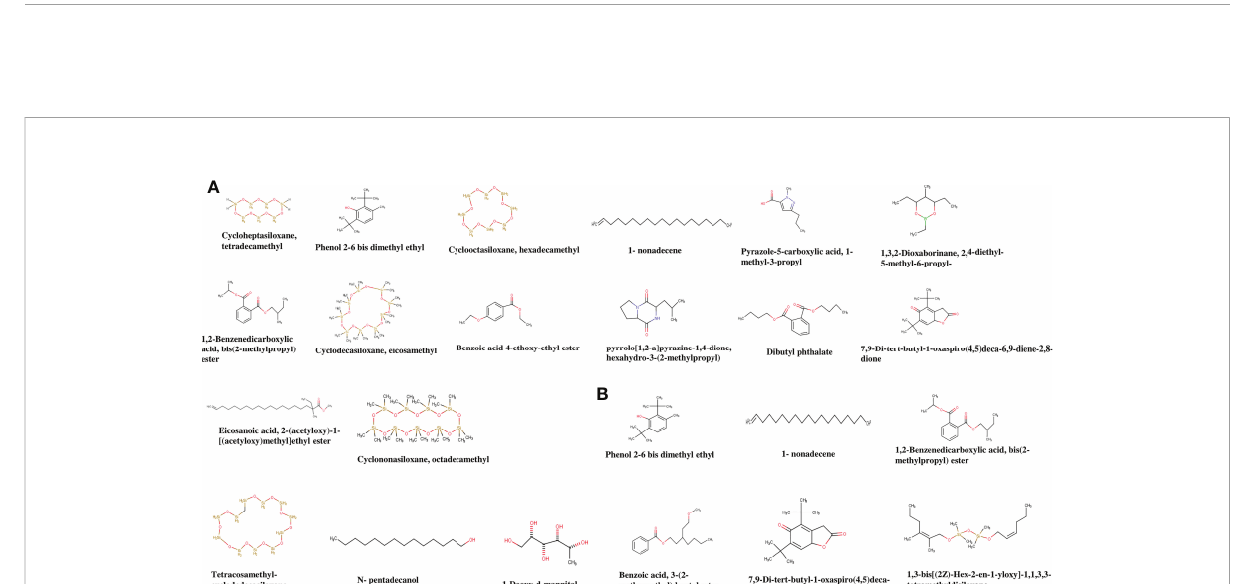
FIGURE 5 Chemical structures of the identi fi ed compounds from the crude extract of (A) Streptomyces sp. VCLA3 and (B) Streptomyces sp.